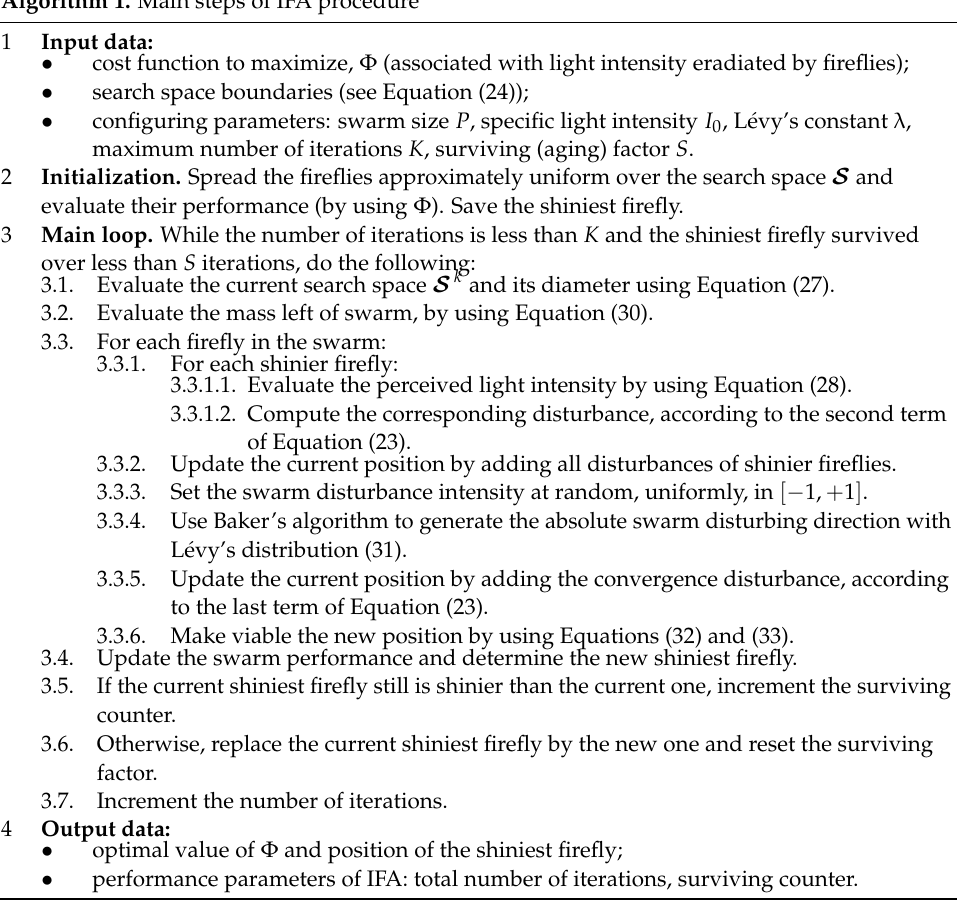
Algorithm 1. Main steps of IFA